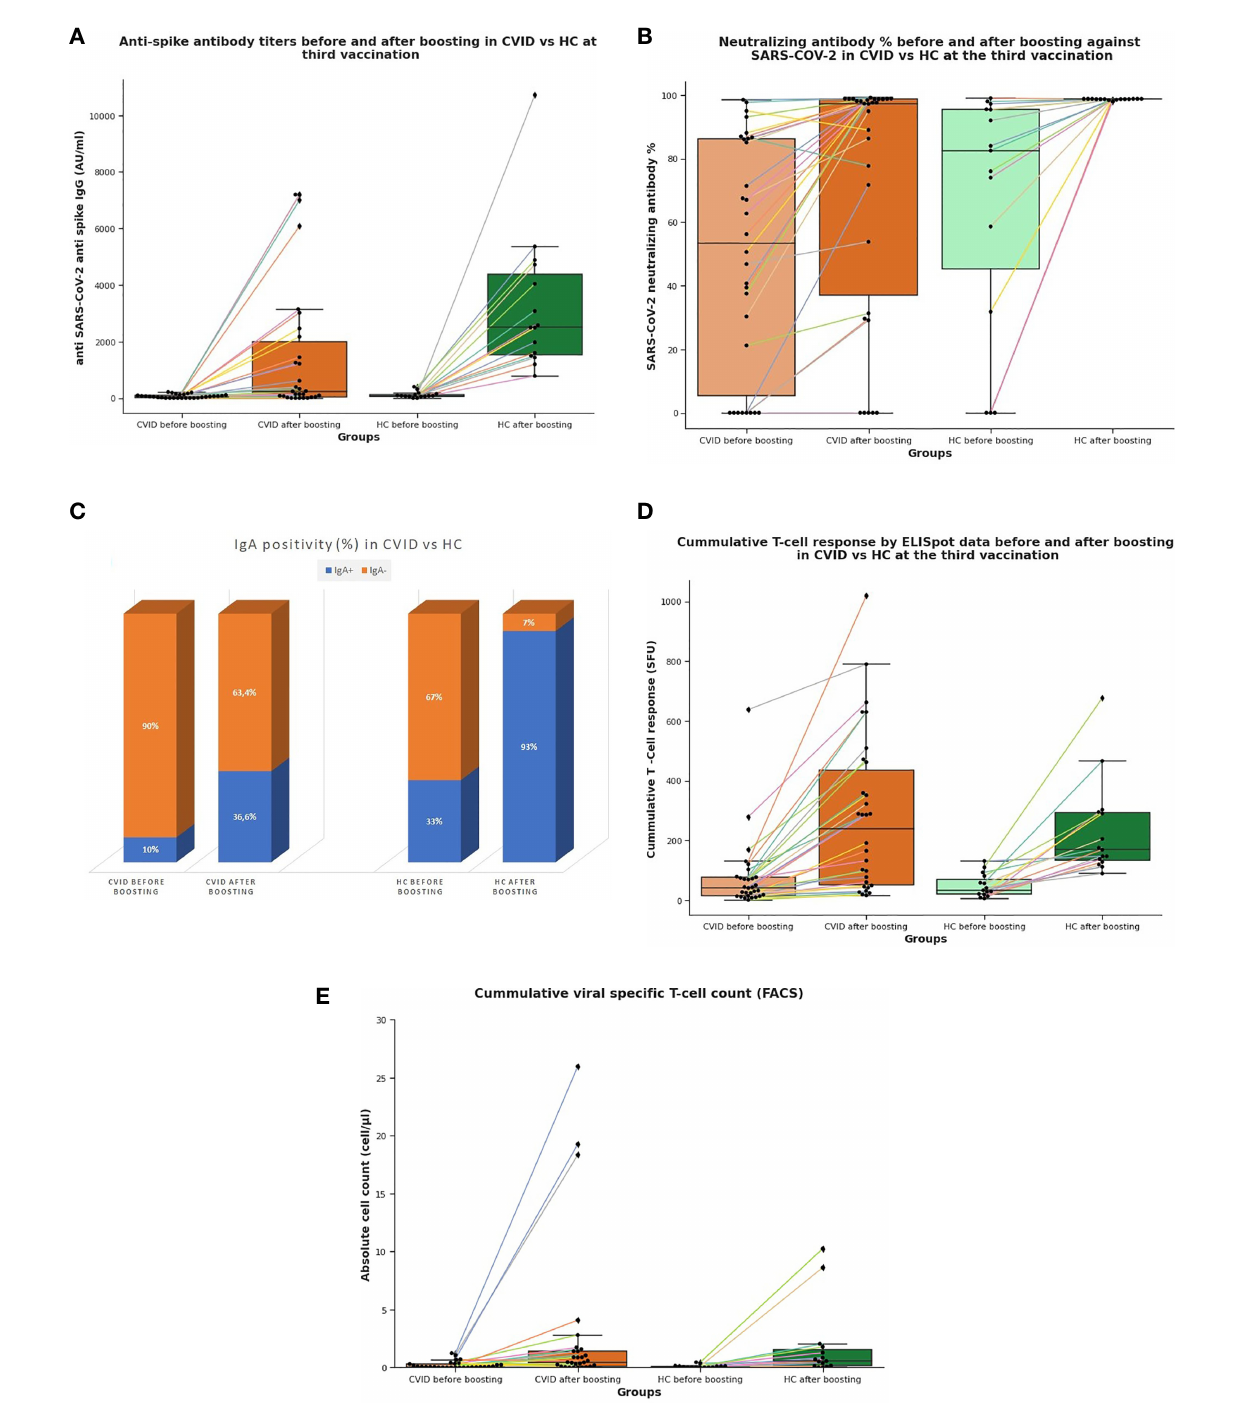
FIGURE 1 | (A) Anti-SARS-CoV-2 spike immunoglobulin G levels (AU/ml) after boosting in CVID is signi fi cantly lower compared to HC at the third vaccination. (B) Neutralizing antibody response (%) against SARS-CoV-2 had been raised close to a 100% after boosting at the third vaccination in healthy controls while the response in CVID had a broad distribution. (C) IgA positivity raised from 10% to 36.6% in CVID and from 33% to 93% among HC. (D) Cumulative T cell response (SFU) by ELISpot is signi fi cantly not different at the third vaccination in CVID from HC before and after boosting. (E) Cumulative viral speci fi c T cell count by fl ow cytometry is signi fi cantly not different at third vaccination in CVID from HC before and after boosting. CVID, common variable immunode fi ciency; HC, healthy control; SARS-CoV-2, severe acute respiratory infection coronavirus 2; SFU, spot forming